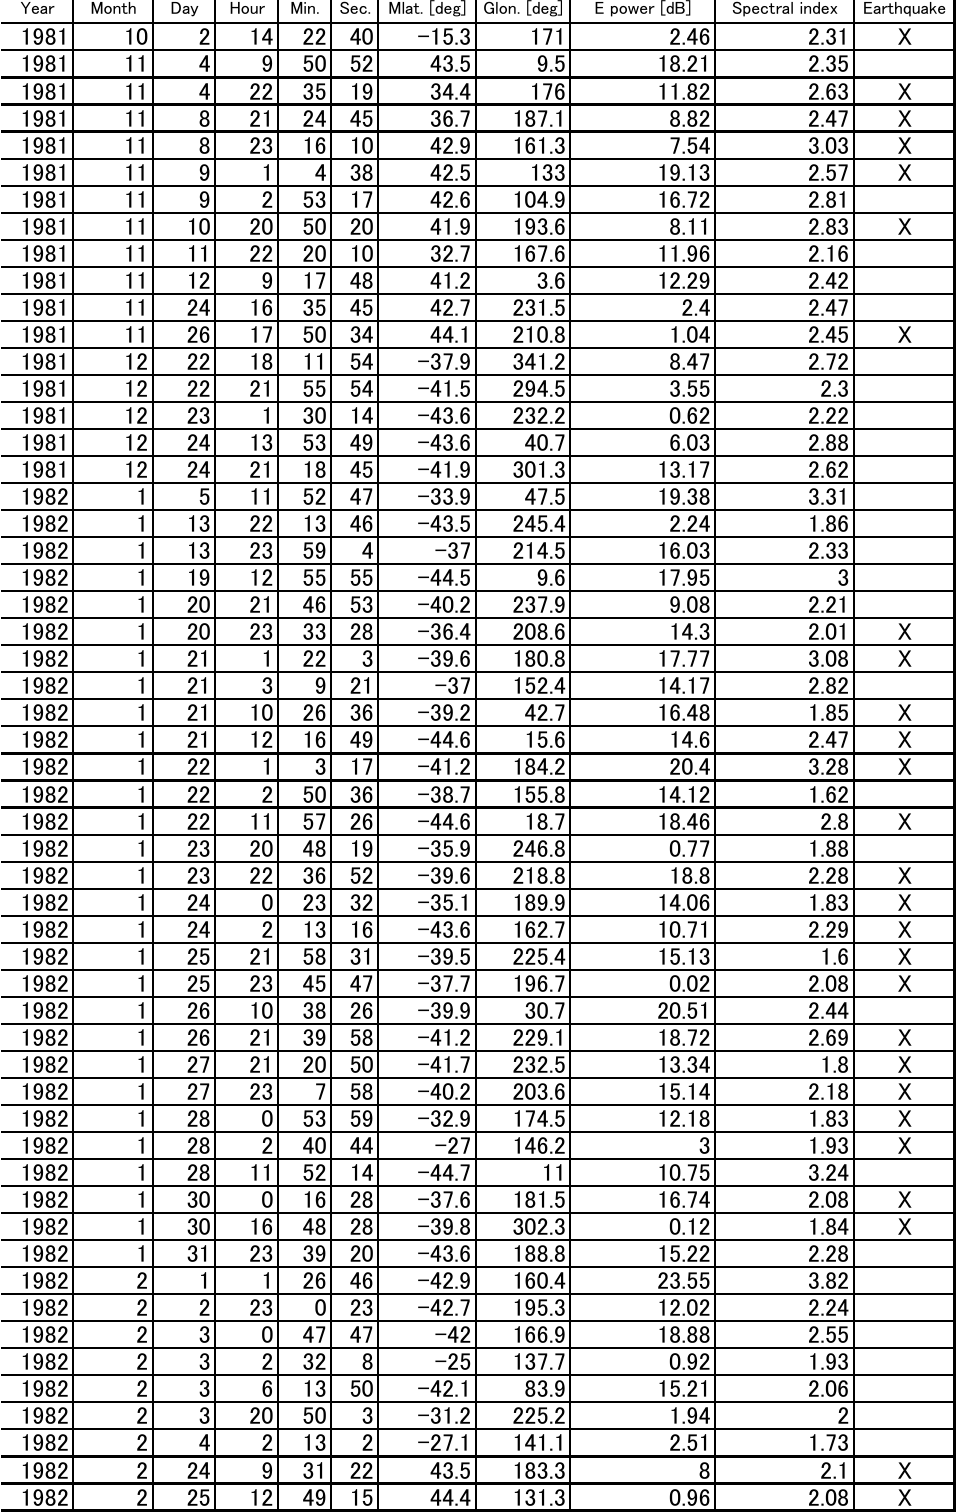
Table 1. List of electric field burst events and related parameters (year, date, time, magnetic latitude, geographic longitude, electric field power, spectral index, and earthquake) used in the statistical study. “X” in the column of the earthquake means that the burst is associated with the seismic activities and no “X” is for the burst without seismic